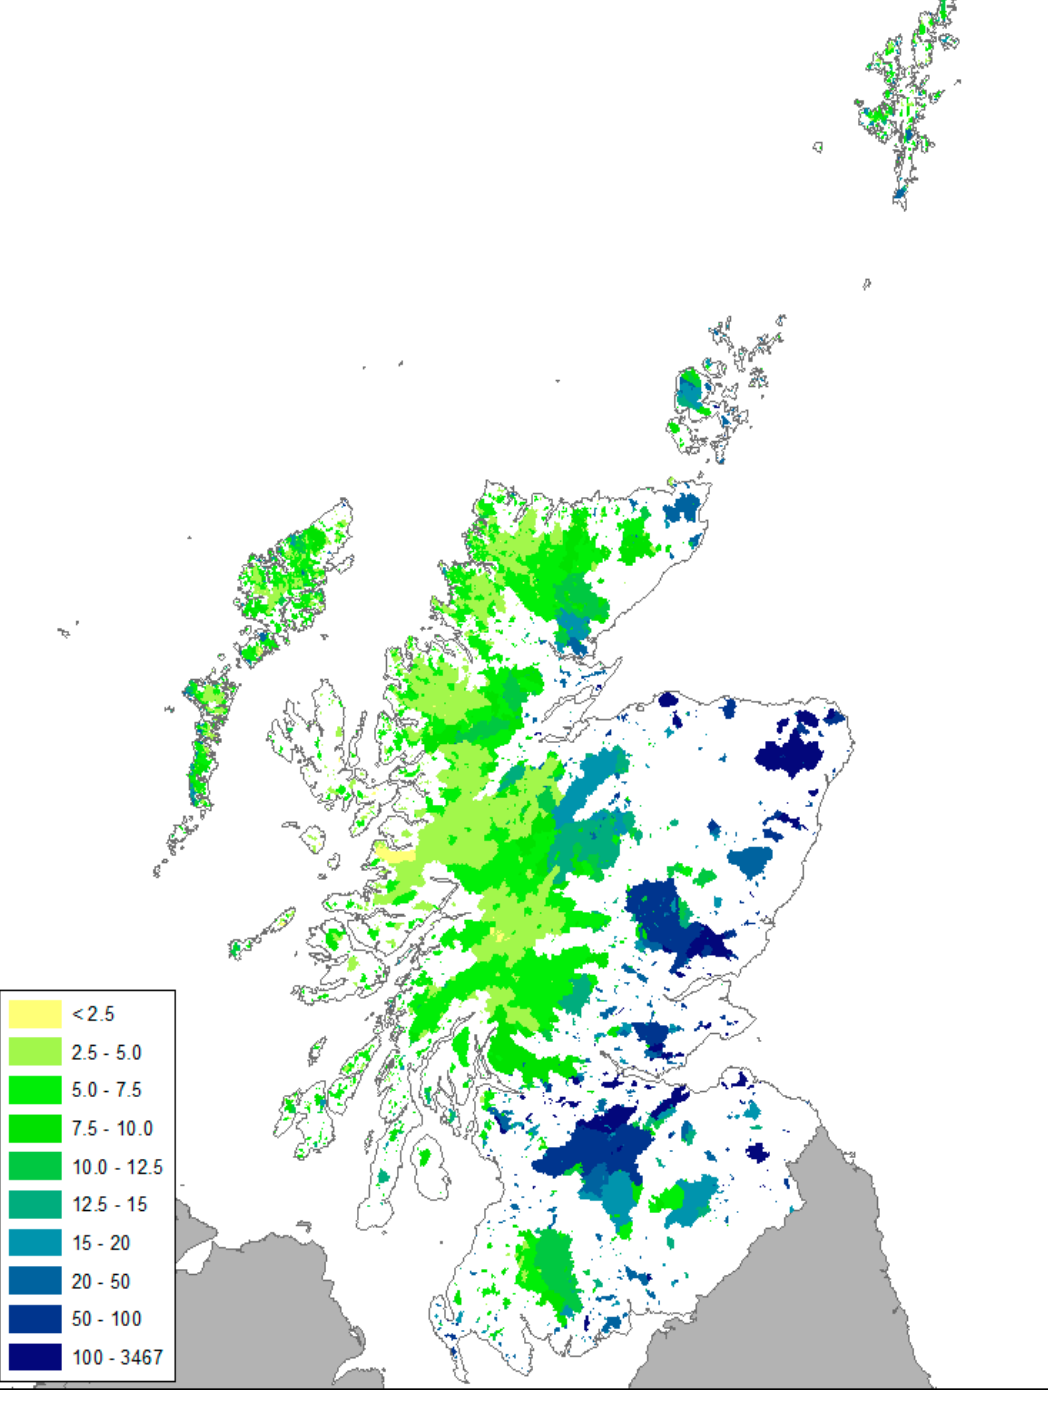
Figure 4. Catchments of all 8030 standing waters showing their estimated in loch P concentrations (µg P/l).